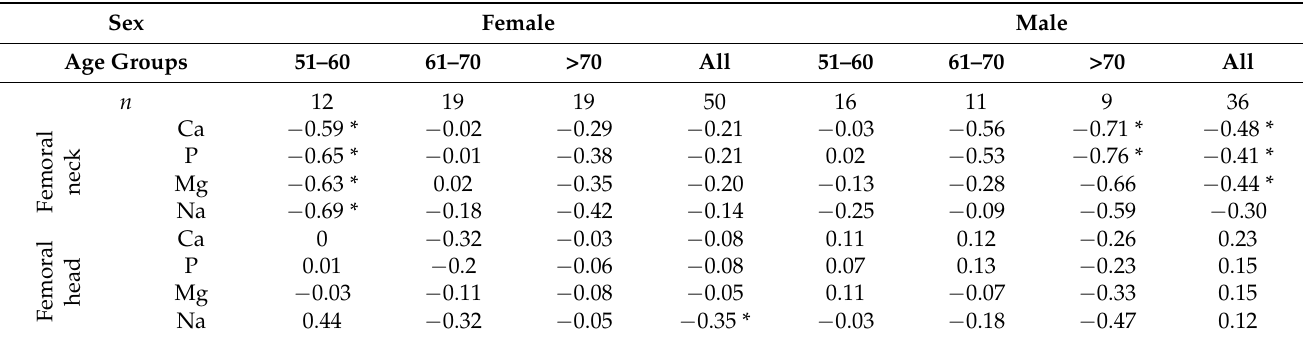
Table 3. Spearman’s correlation coefficient for the content of Ca, P, Mg, and Na in the femoral head and femoral neck and age in the age groups ( N = 86).